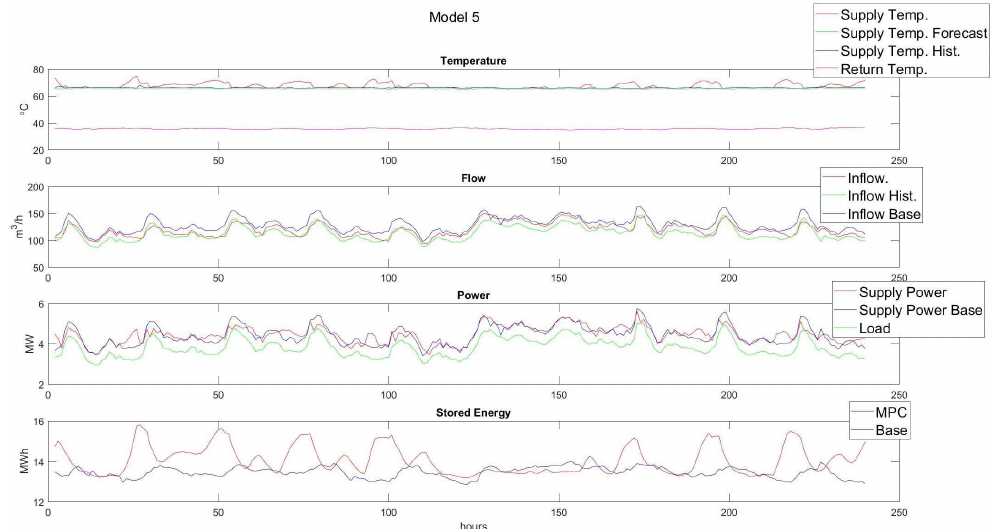
Figure 10. Performance results of model 5, inducing peak shaving, though with an increase in supply temperature. MPC results (red), base simulation (blue), and historic results (green).